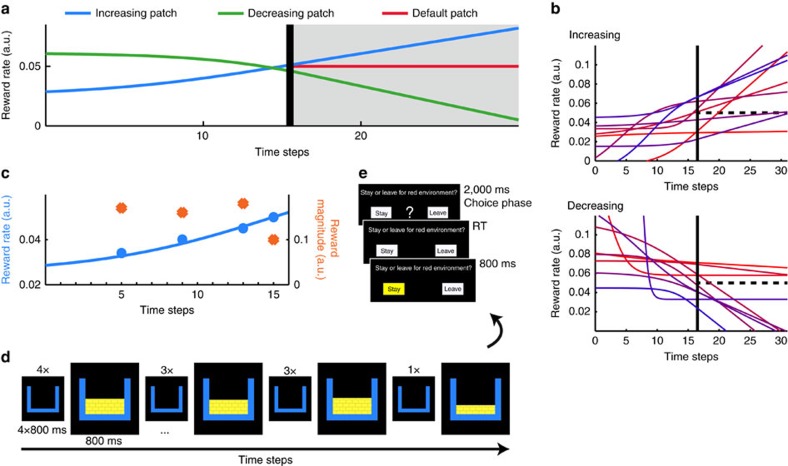
Experimental design and implementation.(a) Two example patches with increasing (blue) and decreasing (green) reward rates. At LSDs (black) subjects chose between staying in the patch and switching to a default patch with a stable reward rate (red). In these examples, correct decisions (stay on blue, leave green) can be predicted from the reward rate curves. (b) All 18 reward rate curves from which trials were derived. Solid black line indicates LSD and vertical dashed line indicates reward rate of reference patch. For visualization purposes only, different colouring for reward rate curves was used, and the curves were aligned so that the LSD is on the same time step. (c) Sequence of events corresponding to the blue reward rate curve before LSD in a. Four reward events were presented at time steps 5, 9, 13 and 15. Their reward rates (blue dots), which conform to the reward rate curve (blue line), are calculated by dividing their reward magnitudes (orange dots) by the time delay from the previous reward event or the start of the patch. (d) Screen during events in c. Empty boxes represent non-reward events; the height of ‘gold bars' in reward events represent their reward magnitudes. Each event was displayed for 800 ms. Between events, a fixation cross was shown and subjects proceeded to the next event by pressing a button. Note that lastRR for this patch would be equivalent to the height of the gold bars in the final box divided by two time steps. (e) LSD followed, without time jitter, after the last reward event (boxes in the default environment were red; therefore, it was labelled ‘red environment' for subjects).